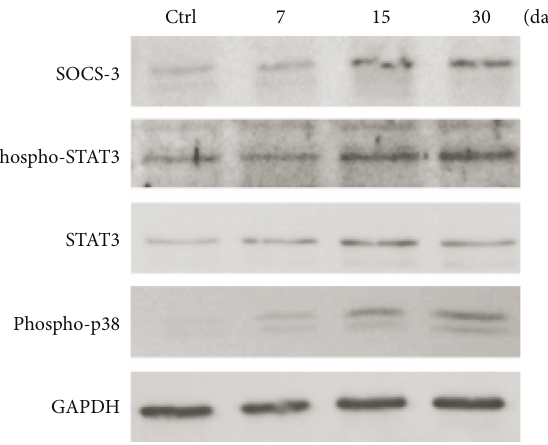
Figure 3: Western blot analysis of SOCS3, STAT3, and p38 MAPK protein expression in the LPS model of periodontal disease. Total protein was extracted from gingival tissue samples obtained from LPS and control sites at 7-, 15-, and 30-day periods. Activation of STAT3 and p38 as well as the expression of SOCS3 was determined. Increases in expression of SOCS3 and in the activation of STAT3 and p38 MAPK were observed at 7-, 15-, and 30-day experimental periods. Note that total STAT3 (including phosphorylated and nonphosphorylated forms) was also increased in the experimental group. The images are representative of the results obtained using samples from three different animals per